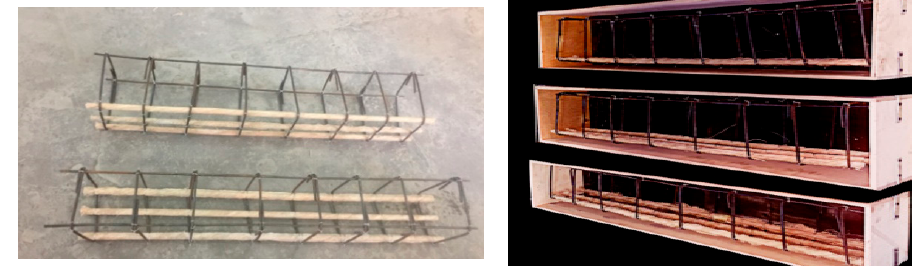
Figure 5. BFRP bars as reinforcement of the tested beams.